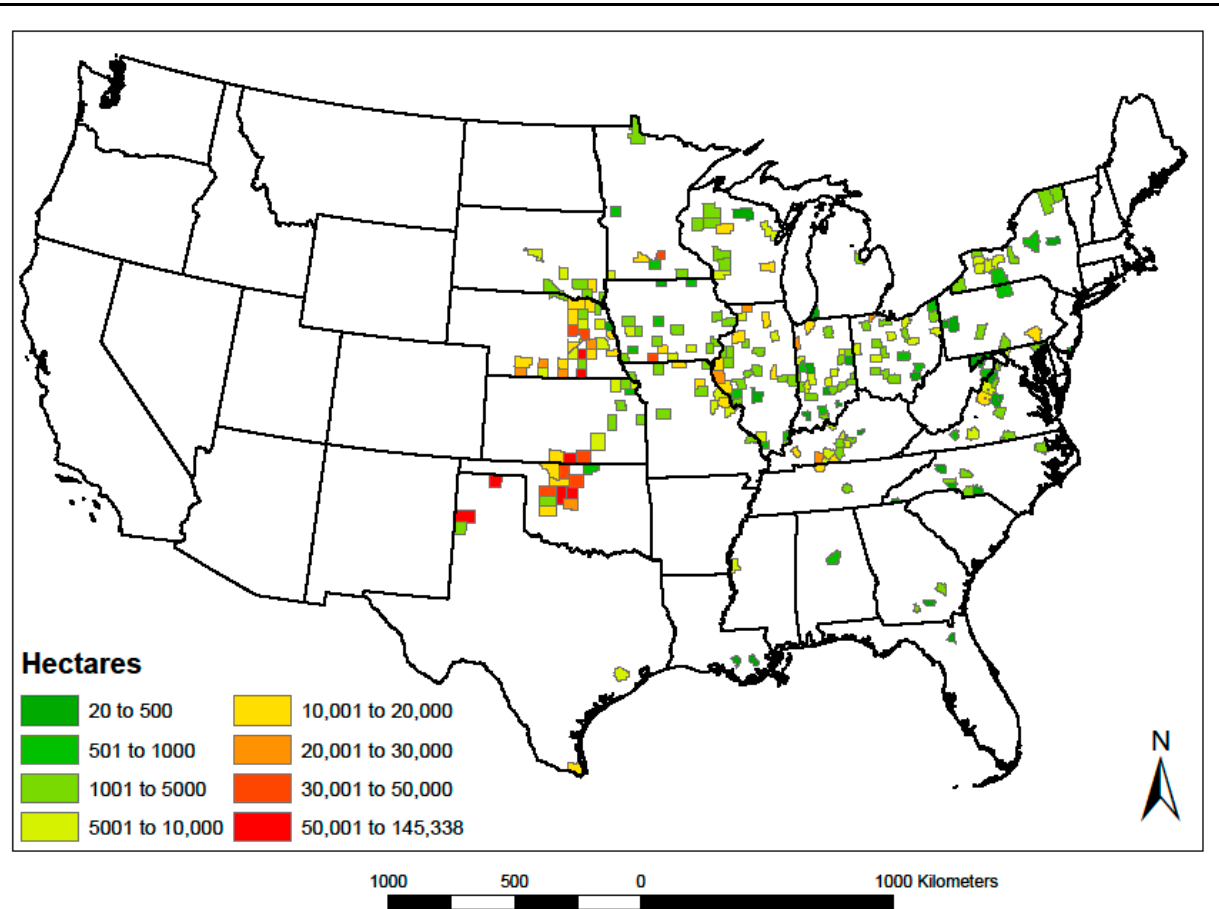
Figure 7. Counties with Increasing Cropland after Removing Available Lands. Map by author.